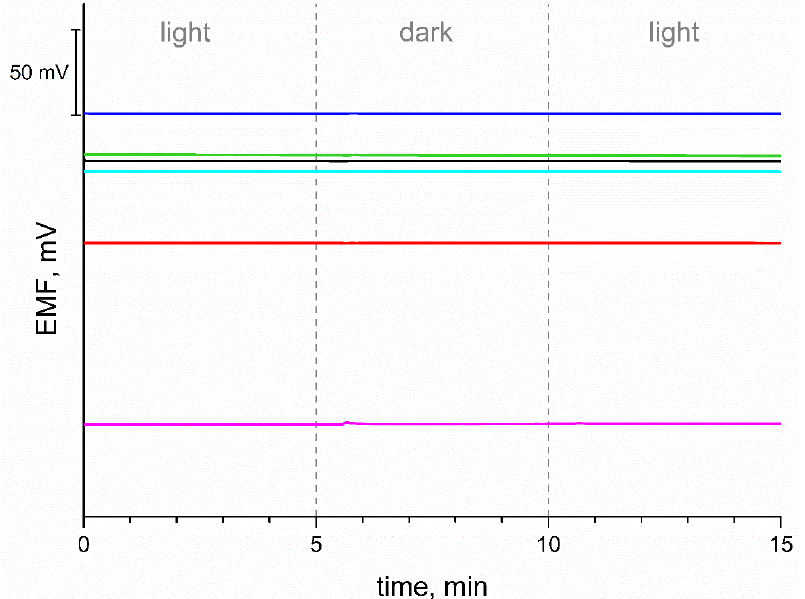
Figure 7. Exemplary potentiometric response during light sensitivity test for GC/eCNF/K + ‐ ISM (blue), GC/eCNF ‐ Co/K + ‐ ISM (cyan), GC/eCNF/CNT[HD] ‐ Co/K + ‐ ISM (green), GC/eCNF/CNT[HD] ‐ NiCo/K + ‐ ISM (black), GC/eCNF/CNT[LD] ‐ NiCo/K + ‐ ISM (red) and coated disc electrode (magenta).